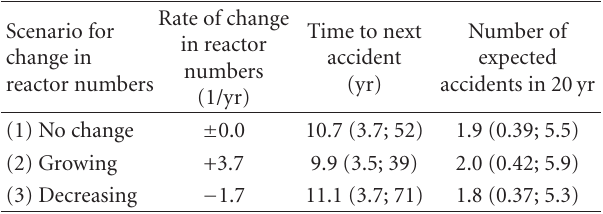
Table 3: Point estimates for the time to the next reactor accident with INES level ≥ 5 and the number of expected accidents within 20yr for three scenarios concerning the change of the world’s reactor numbers (95% CI in